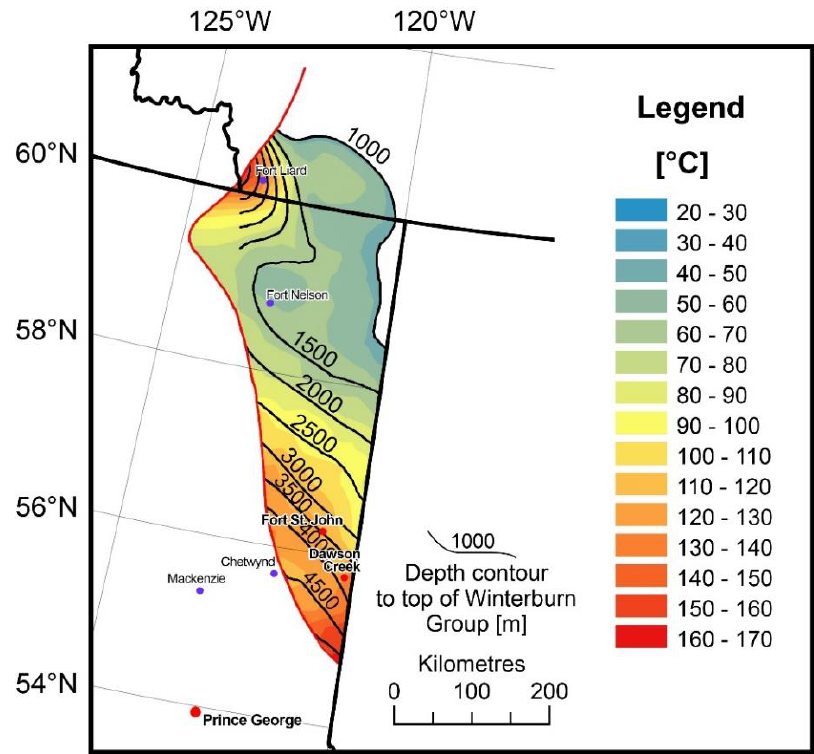
Figure A10. Temperatures top Winterburn Group—NE British Columbia S. NWT WCSB.